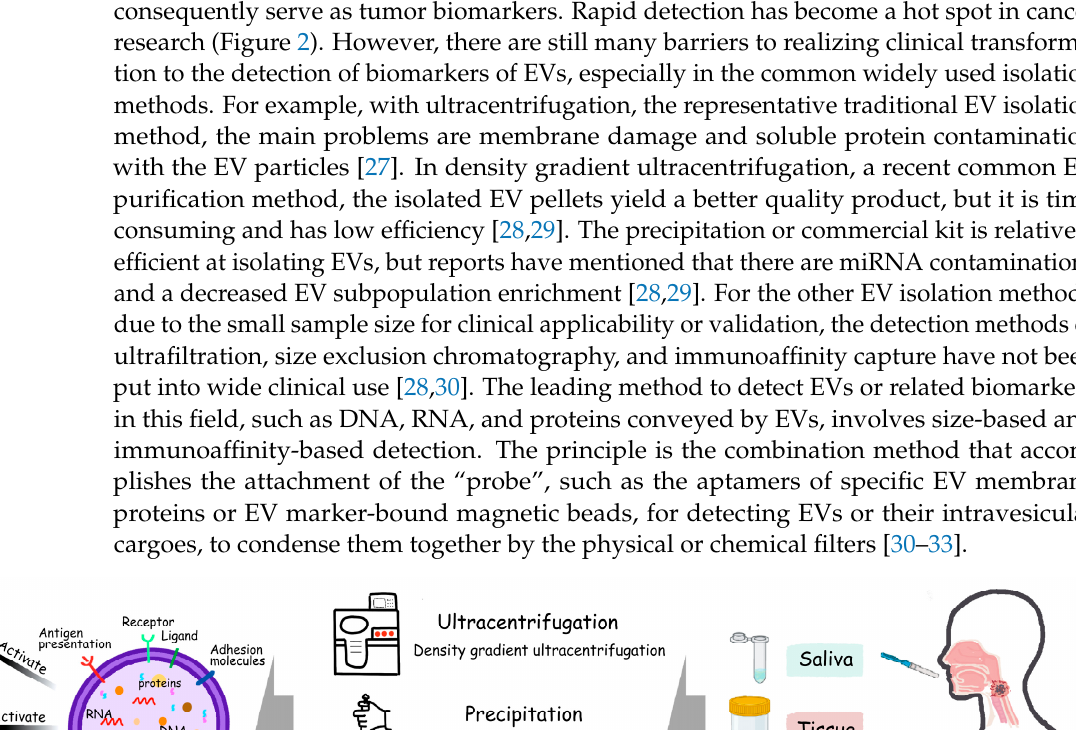
4 of 22 Figure 1. Biogenesis of EV subtypes and their transporting mode. Early endosomes sprout inwards from the cell membrane to form intraluminal vesicles, engulf intracellular components (such as RNAs, proteins, and other metabolites), transform into multivesicular bodies and then release exo- somes into extracellular space. As for microvesicles, they bud from plasma membrane, and accepted by recipient cells via ( a ) direct fusion, ( b ) phagocytosis, ( c ) receptor-mediated or not endocytosis. EVs could be identi fi ed and extracted by liquid biopsy as cell-free DNA and circulating tumor cells. EVs from di ff erent origins consist of various components and present with cell-type- speci fi c proteins. Even from the same cell of origin, the contents of EVs vary with di ff erent stimuli and microenvironments, and consequently, they have corresponding fates and functions. Since EVs were discovered, there has been the notion that EVs could potentially contribute to oncogenesis, metastasis, resistance to chemotherapy, and therefore, conse- quently serve as tumor biomarkers. Rapid detection has become a hot spot in cancer re-